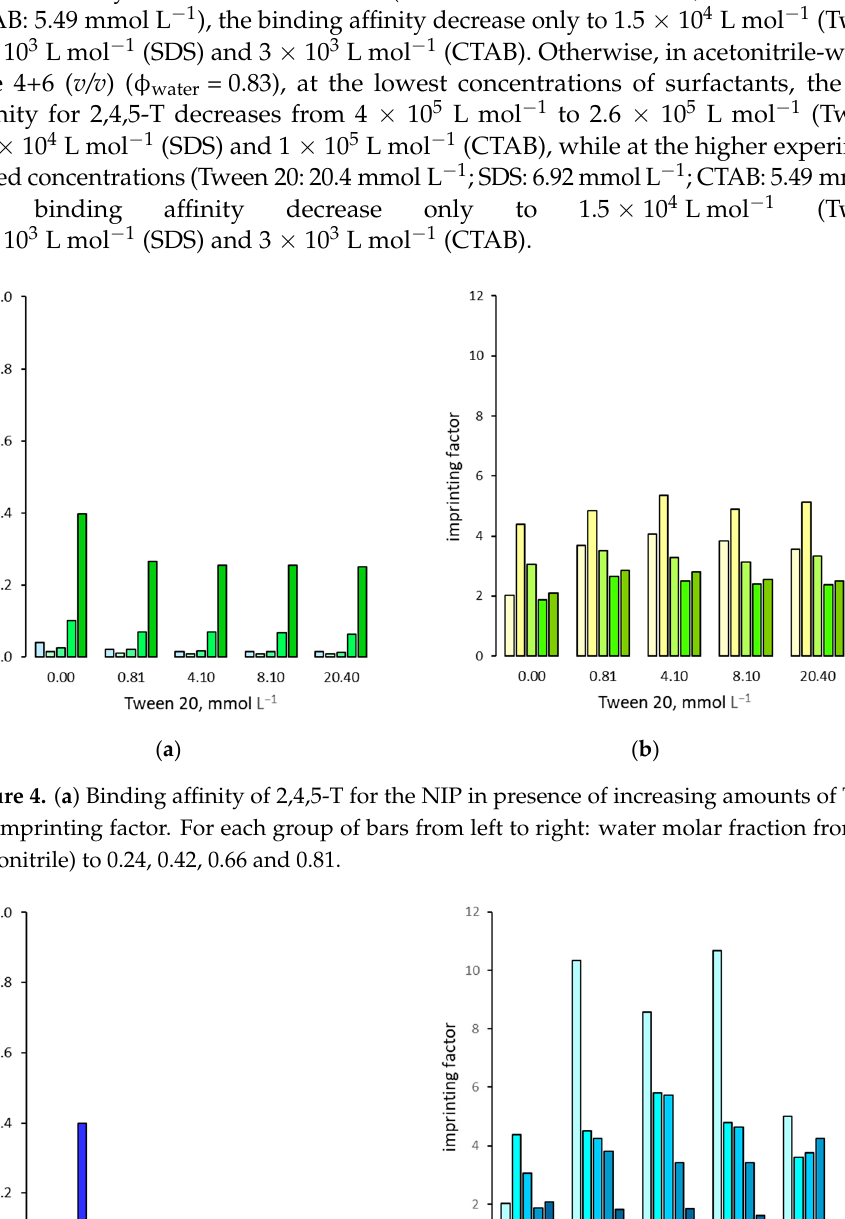
( b ) Figure 6. ( a ) Binding affinity of 2,4,5-T for the NIP in presence of increasing amounts of CTAB; ( b ) Imprinting factor. For each group of bars from left to right: water molar fraction from 0 (pure ace- tonitrile) to 0.24, 0.42, 0.66 and 0.81. 3.3. Effect on the Binding Selectivity Regarding the effect of surfactants on the binding selectivity, as reported in Figures 7–9, the binding affinities measured for 2,4-D mirror those for 2,4,5-T: a minimum in the presence of a solution rich in acetonitrile ( ϕ water = 0.24), followed by a progressive and significant increase as the molar fraction of water rises. In addition, increasing amounts of surfactant exerts a depressive effect on binding affinity, confirming a general tendency to decrease as the concentration of surfactant increases. It must be noted that, despite the close similarity in the binding affinity trends measured in the presence of surfactants be- tween 2,4,5-T and 2,4-D, small differences within the pair of equilibrium binding constant values can change the resulting binding selectivity. In fact, in the presence of Tween 20, the α -values show no significant changes compared to those measured in the absence of surfactant, while in the presence of SDS, a limited but significant increase can be observed but only for acetonitrile-rich mixtures ( ϕ water = 0–0.24). Lastly, contrary to what happens in the absence of surfactant, in the presence of CTAB the α -values increase progressively as the molar fraction of water increases.